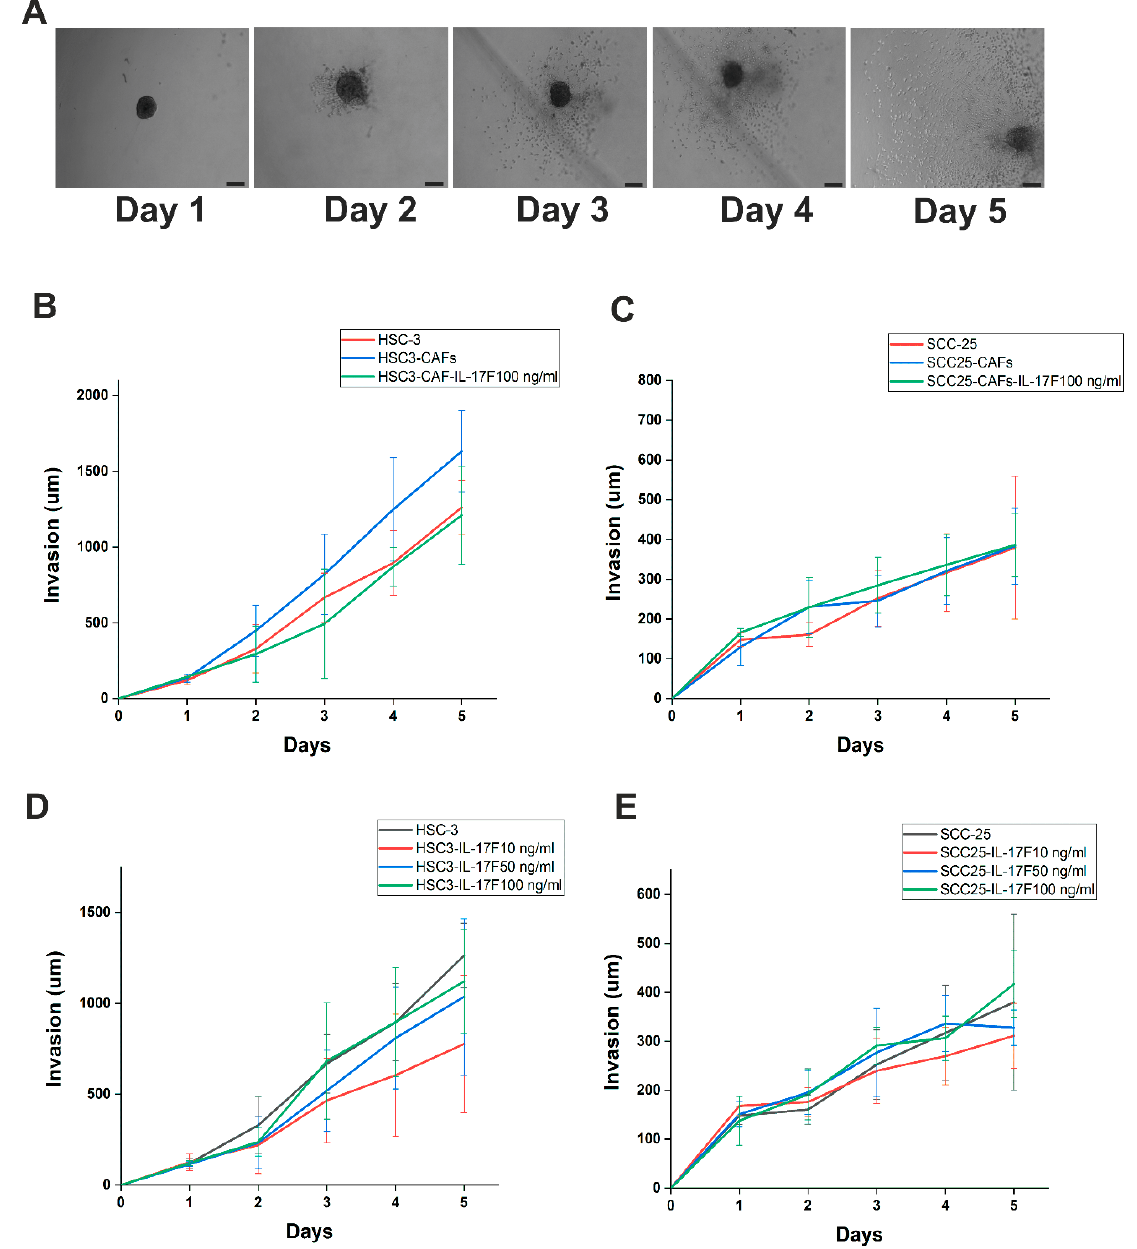
Figure 6. IL-17F prevents the pro-invasive effect of cancer-associated fibroblasts (CAFs) and reduces cancer cell invasion in tumor spheroids. ( A ) Representative figures of HSC-3/CAFs spheroids (Days 1 to 5). Scale = 200 µm. ( B ) The invasion of HSC-3 was enhanced when cells were combined with CAFs (HSC-3/CAFs) rather than with HSC-3 alone. This effect was abolished with addition of 100 ng/mL IL-17F. ( C ) IL-17F had no consistent effect on SCC-25 cell invasion ( D , E ) No significant effects of IL-17F on cancer cell invasion were observed when they were cultured without CAFs. Data are presented as means ± standard deviations.